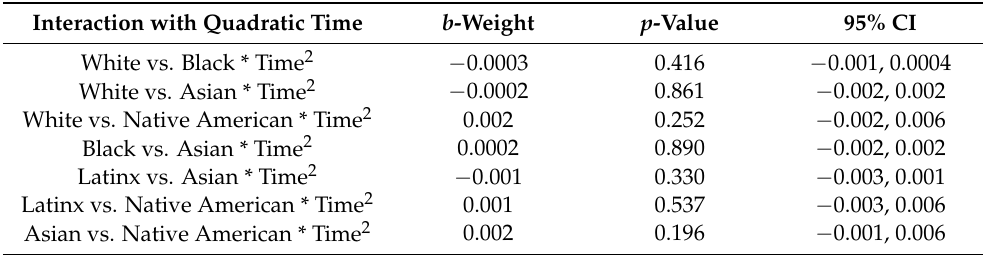
Table 4. Examining differential change in arrest probability trajectories over time as a function of race/ethnicity.